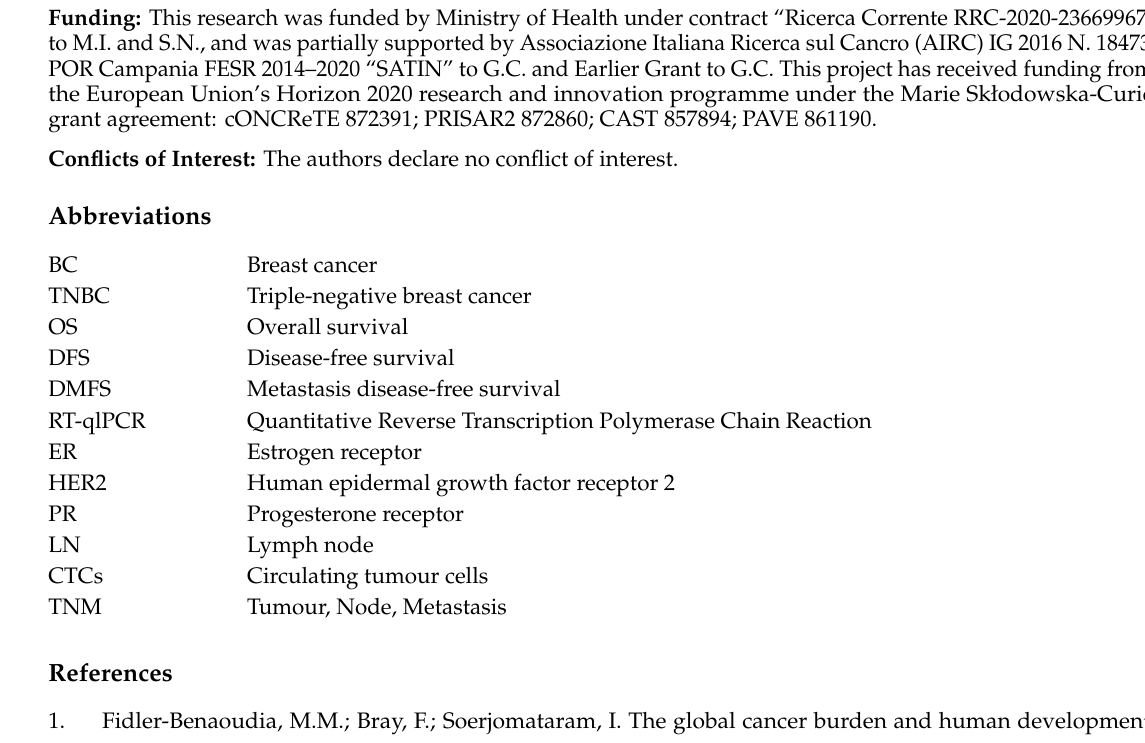
Table S1: Key terms used in literature search, Table S2: PRISMA